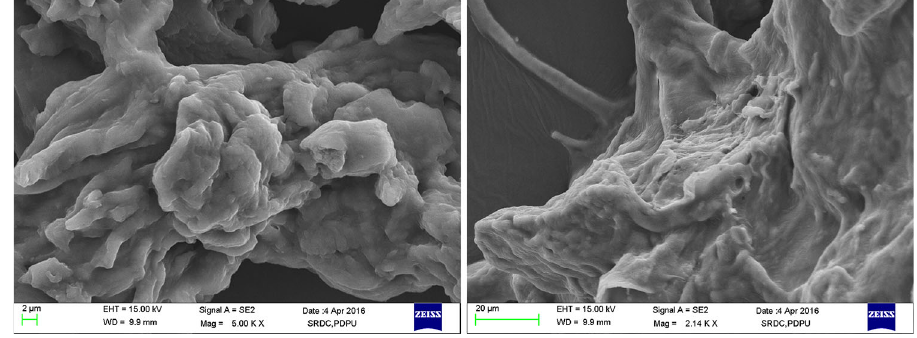
Fig. 2 SEM image of XCP mud cake